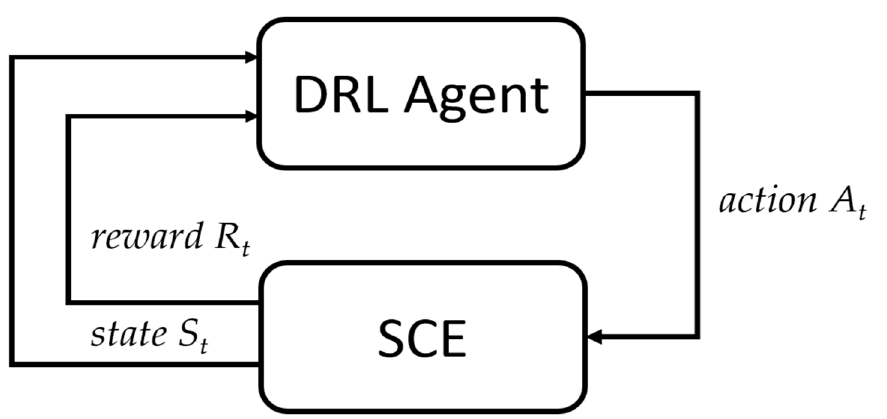
Figure 1. Agent–environment relations in a Markov decision process.